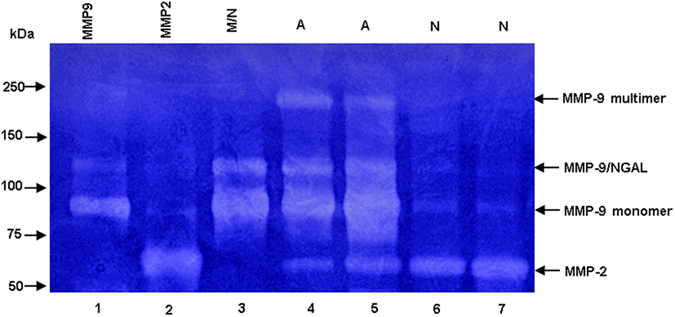
Gel zymography analysis of enzymatic levels of MMP-9 and MMP-2 in AVMs and normal tissues.RhMMP-9 (lane 1), rhMMP-2 (lane 2) and purified neutrophil MMP-9/NGAL complex (lane 3) were used as positive controls; lanes 4–5, AVMs; lanes 6–7, normal tissues.